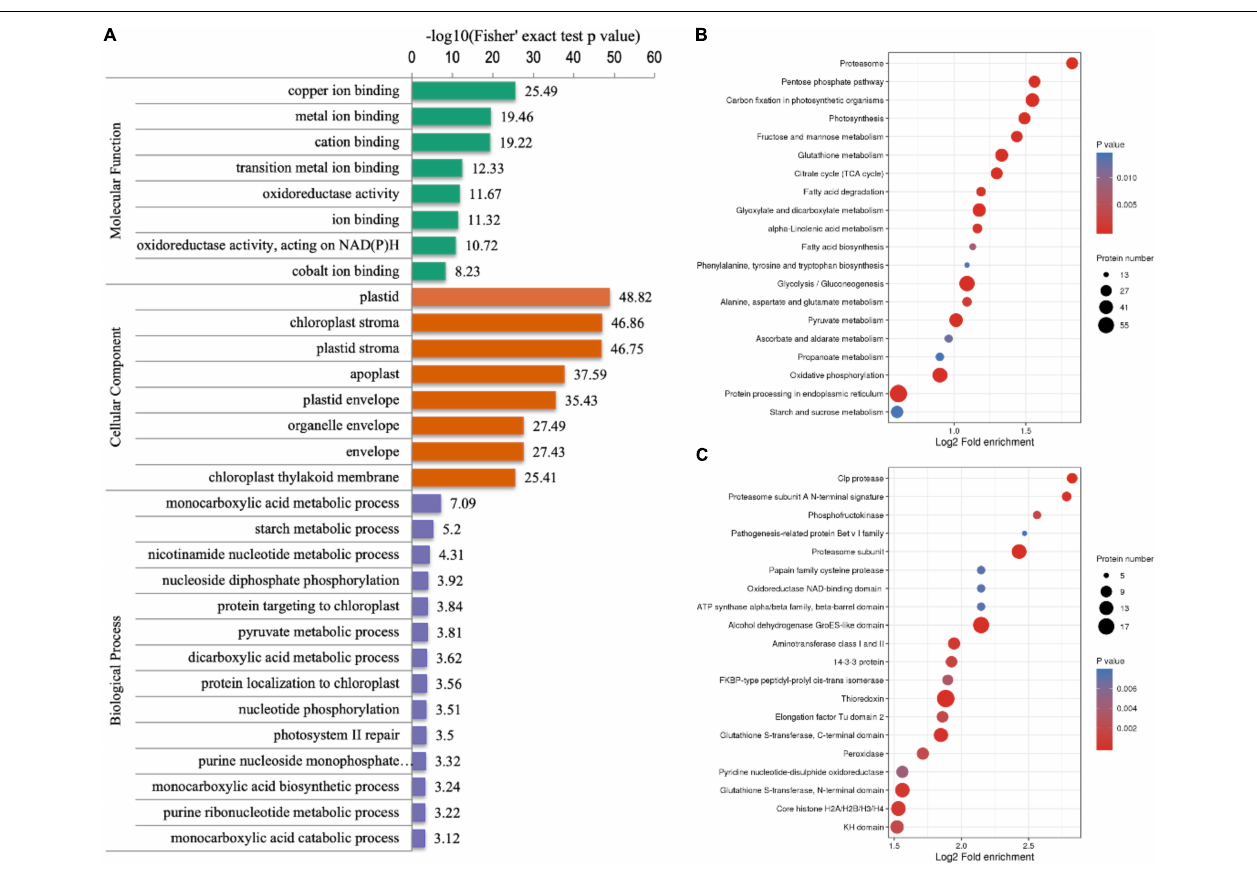
FIGURE 3 | The GO classification, the Kyoto Encyclopedia of Genes and Genomes (KEGG) pathway and protein domain analyses of crotonylated proteins of D. huoshanense . The p -value obtained by the Fisher’s exact test showed the functional classification and pathway of enriched proteins. The results of the first 20 classifications most enriched were given in the bubble plot. In the bubble plot, the vertical axis is the functional classification or pathway and the horizontal axis value is the Log2 conversion value of the proportion of modified proteins in this functional type compared with the proportion of identified proteins. The circle color indicates enrichment significance and the circle size indicates the number of modified proteins in the functional class or pathway. (A) The GO enrichment bubble plot of proteins corresponding to modification sites in three categories: biological process, molecular function, and cellular component. (B) The KEGG pathway enrichment of proteins corresponding to modification sites. (C) Protein domain enrichment bubble